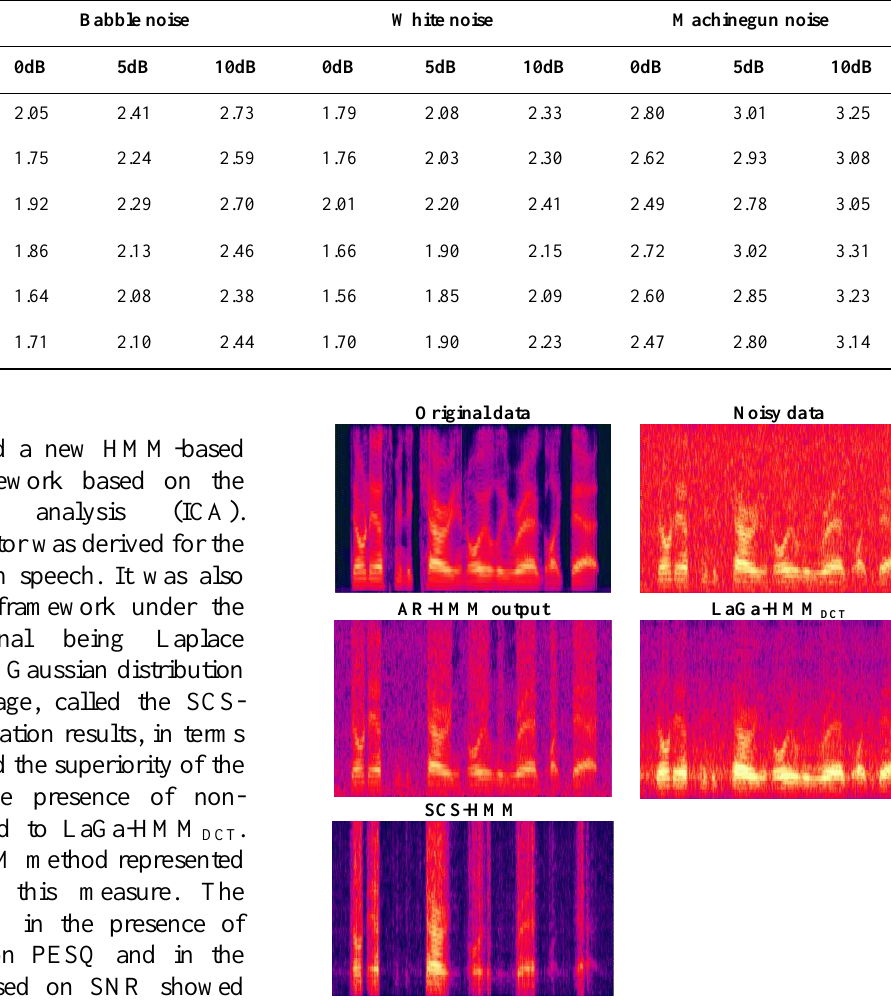
Table 2. Comparative performance in terms of PESQ.